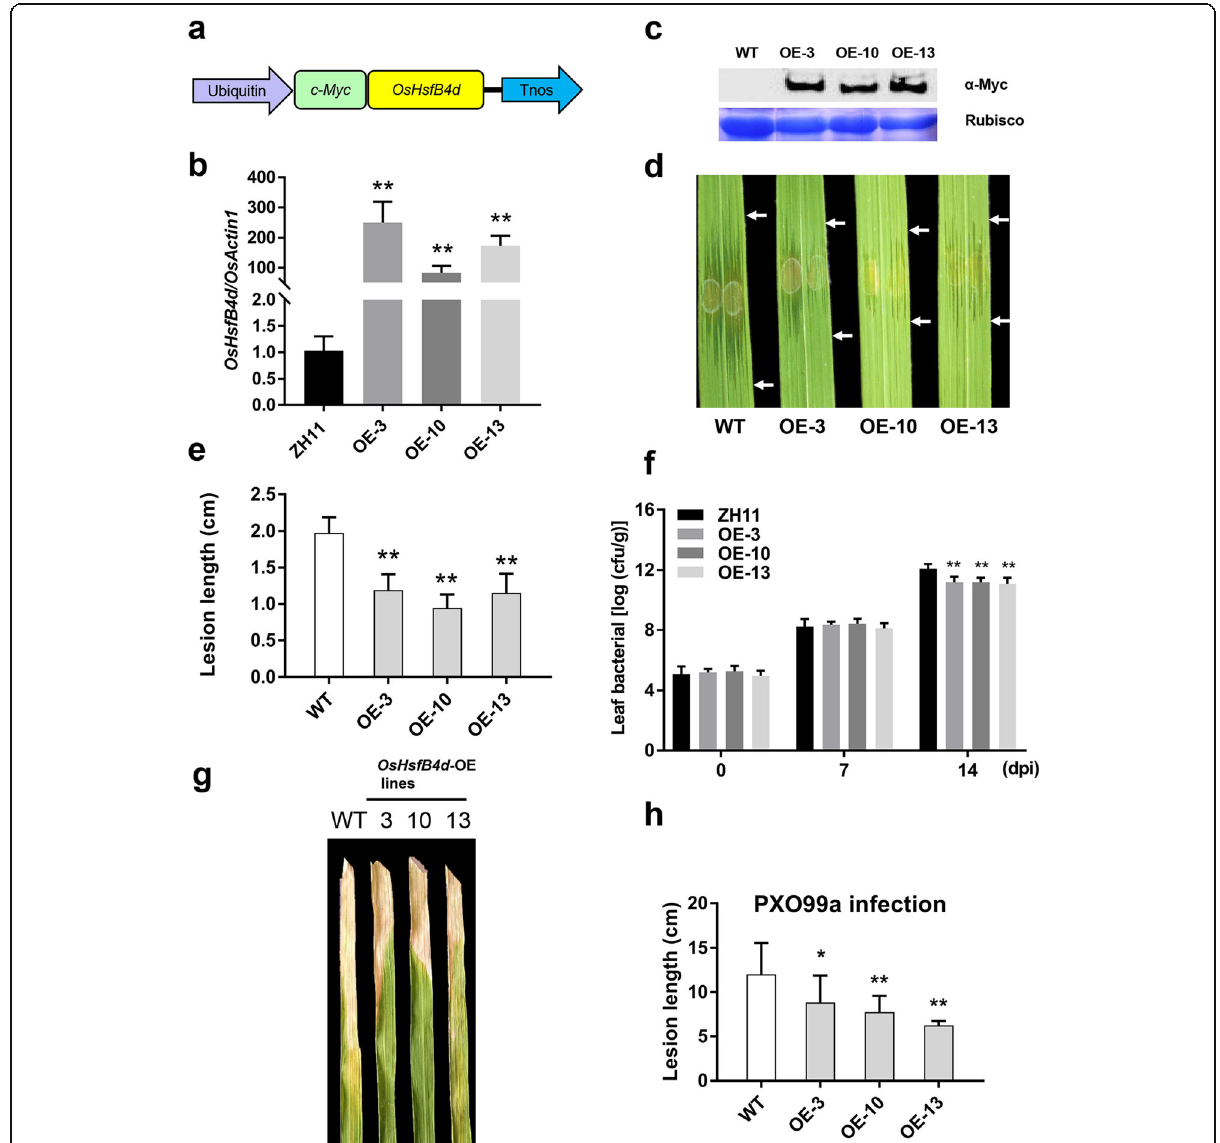
Fig. 3 Resistance performance of transgenic OsHsfB4d OE plants from the T 2 generation. a Diagram of the OsHsfB4d overexpression construct. b Relative expression levels of OsHsfB4d in three identified T 2 transgenic lines. OsActin was used as an internal control. Bars represent the mean (three replicates for gene expression)±SD. c Immunoblot analysis of OsHsfB4d in transgenic lines. Total protein extracts were separated by SDS- polyacrylamide gel electrophoresis (SDS-PAGE) and probed with antibodies against the c -Myc tag ( α -Myc). The stained Rubisco protein shows that equal amounts of protein sample were loaded. The immunoblot band shows OsHsfB4d-Myc of approximately 35 kD. d Representative lesion sites in OsHsfB4d OE leaves at 14 dpi with Xoc strain RS105. e Lesion lengths scored for T 2 transgenic plants with pCXUN::OsHsfB4d. Eight individuals were scored for each line and the WT. “ ** ” indicates significant ( t test, P <0.01) differences ( n =16). f Bacterial population growth in leaves from OsHsfB4d OE and WT plants inoculated with RS105. Colonies were counted with the leaf segment up to 5cm from the inoculation site. Error bars represent the standard deviation of three independent leaves. The bars represent the mean±SD. “ ** ” indicates significant ( t test, P <0.01) differences. g The phenotypes of the PXO99a lesions that developed on ZH11 and OsHsfB4d-OE lines at 14 dpi. h Lesion lengths were scored for OsHsfB4d-OE lines ( n = 10). Asterisks indicate significant difference between transgenic and wildtype (WT) plants at ** P <0.01 or * P coincided with the increased level of OsHsp18.0-CI ex- pression and the resistance performance of the three OE lines. These results indicated that the OE lines may en- hance BLS resistance by activating the expression of OsHsp18.0-CI and PR genes.